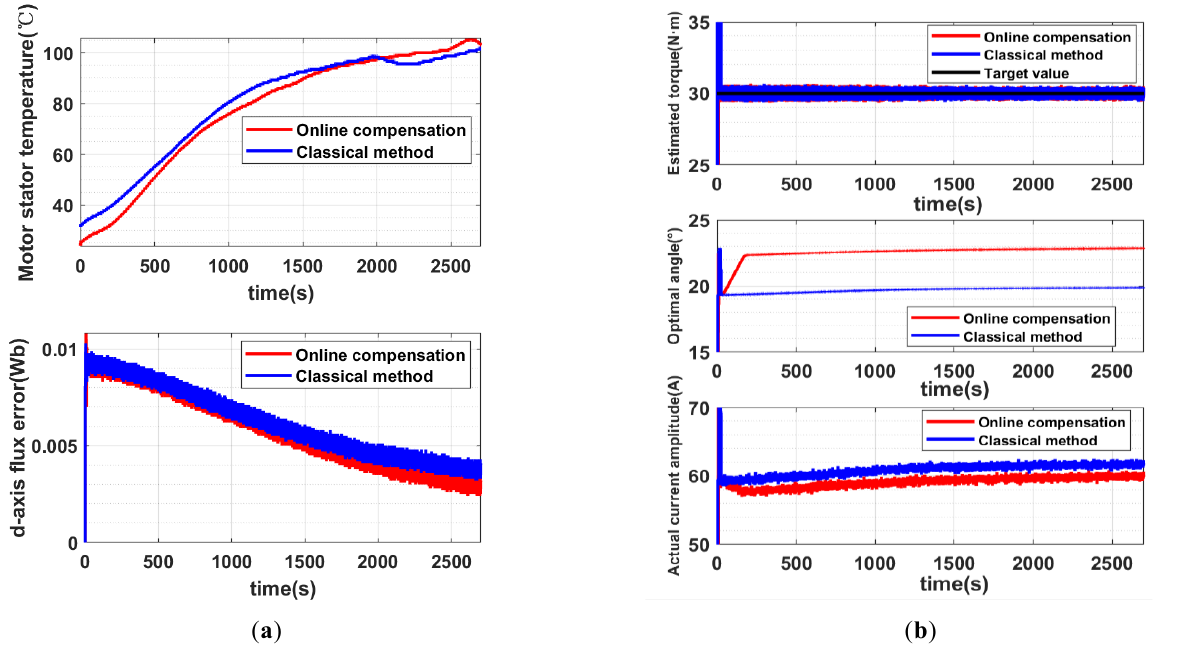
Figure 22. Test results of torque compensator during temperature rise ( a ) temperature rise result;